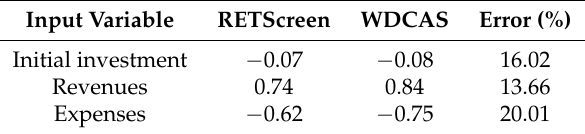
Table 6. Impact of input variables on the net present value by using RETScreen and WDCAS